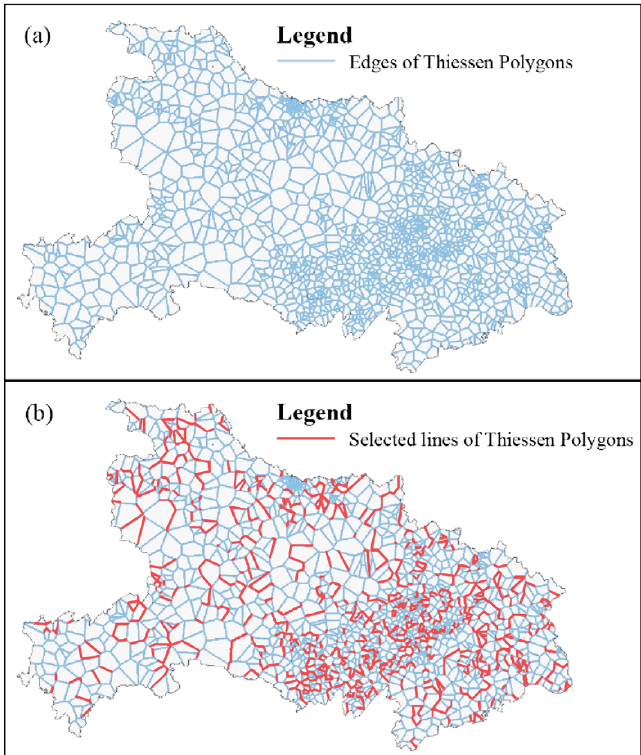
Figure 5. Unextracted and extracted lines from the Thiessen polygon edges, ( a ) unextracted lines from the Thiessen polygon edges; ( b ) extracted lines from the Thiessen polygon edges.